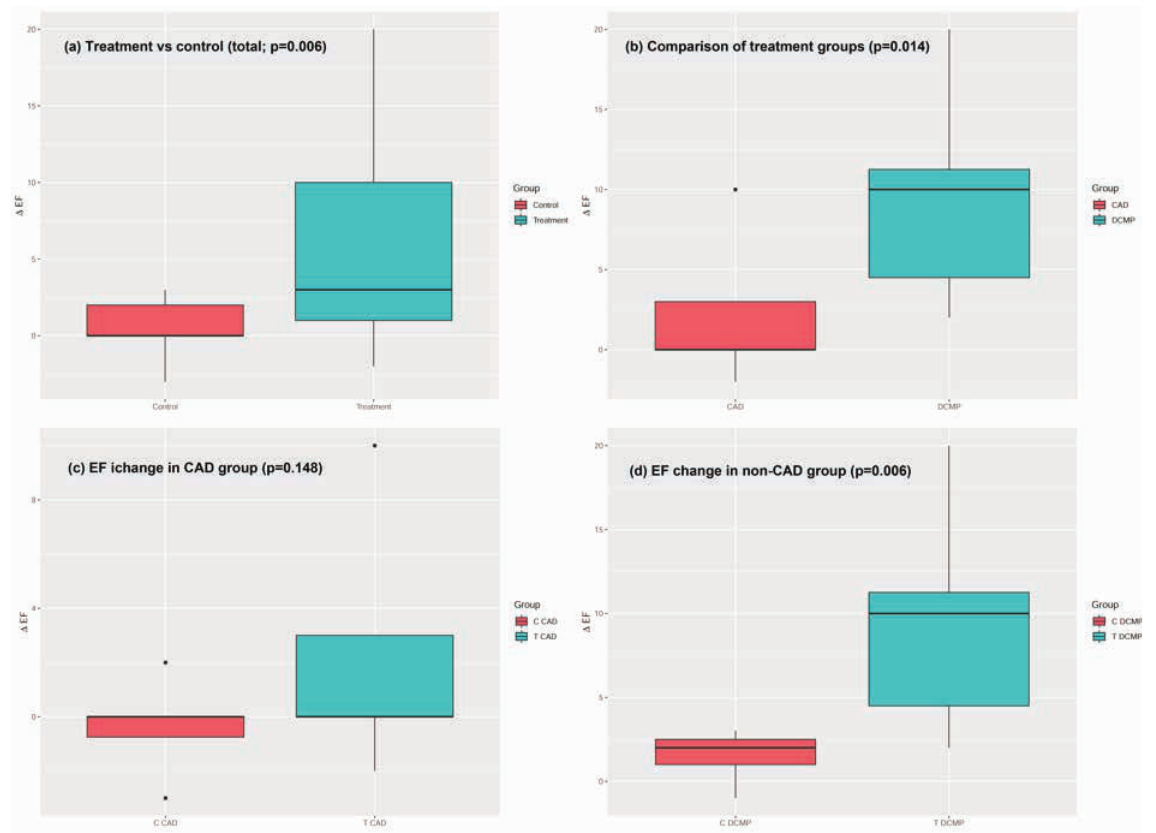
Figure 2: Change of LVEF in the individual categories according to etiology and treatment/control groups; (a) overall treatment (right) vs control (left) group regardless of etiology; (b) treatment groups by etiology (CAD – left, non-CAD – right); (c) control (left) vs treatment (right) group in patients with CAD etiology; (d) control (left) vs treatment (right) group in patients with non-CAD